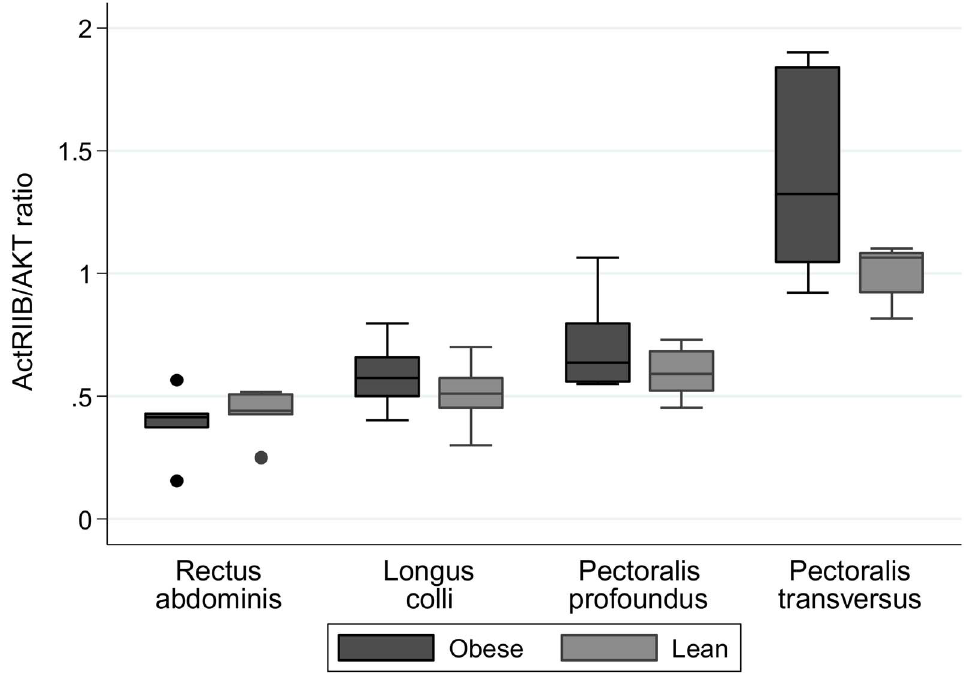
Figure 4. Protein expression of ActRIIB protein in skeletal muscles of lean and obese horses and ponies. Protein expression of ActRIIB protein ( , 50 kDa) was assessed by Western blot with total AKT used as a loading control. Mean densitometric signals were calculated from three independantly repeated Western blots. n=6/group.